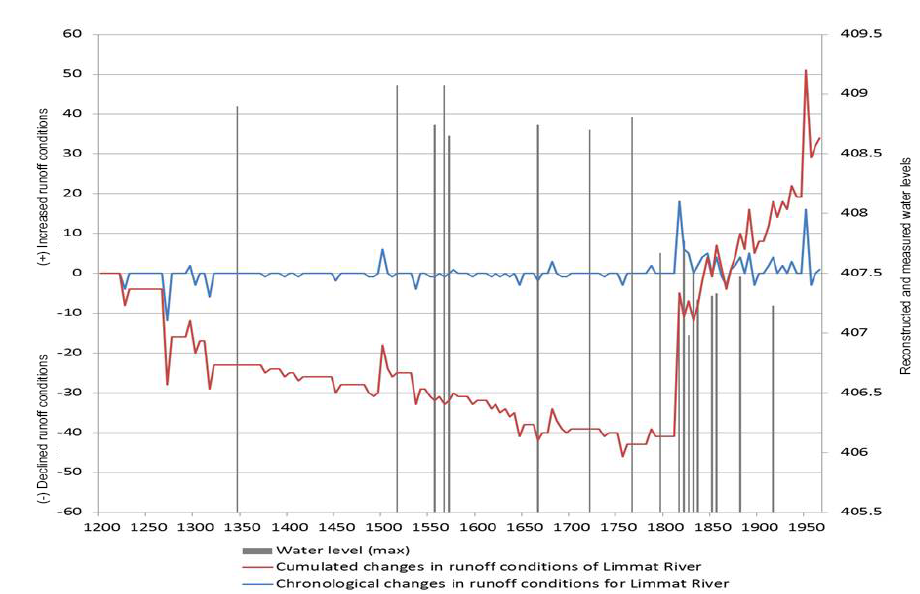
Figure 11. Changes in runoff conditions of the Limmat River in Zürich.